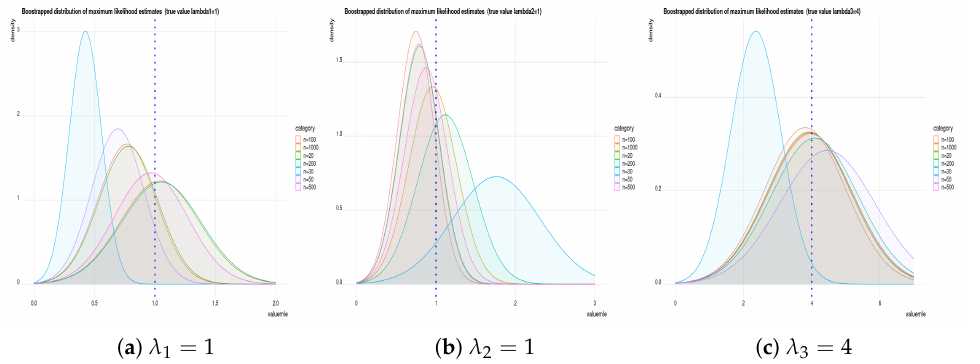
Figure 4. Boostrapped distribution of ( λ 1 , λ 2 , λ 3 )